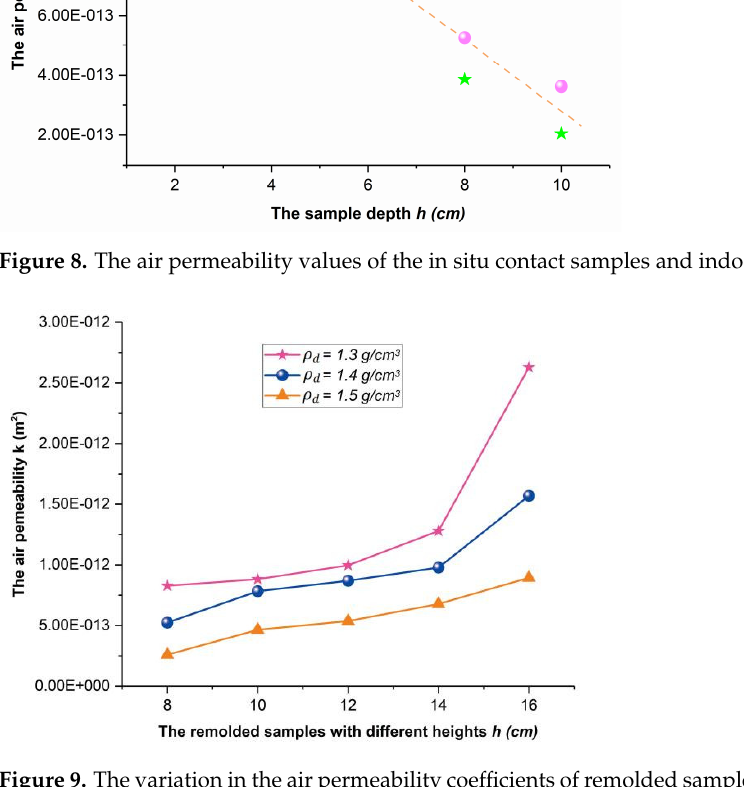
Figure 10. The air permeability of remolded loess samples. With the increase in the buried depth of undisturbed air-dried loess, the overlying load of the soil increases, which results in particle compaction, a significant decrease in the numbers of macropores and mesopores, and an increase in the number of small holes and micropores. Macropores and mesopores play a leading role in the process of